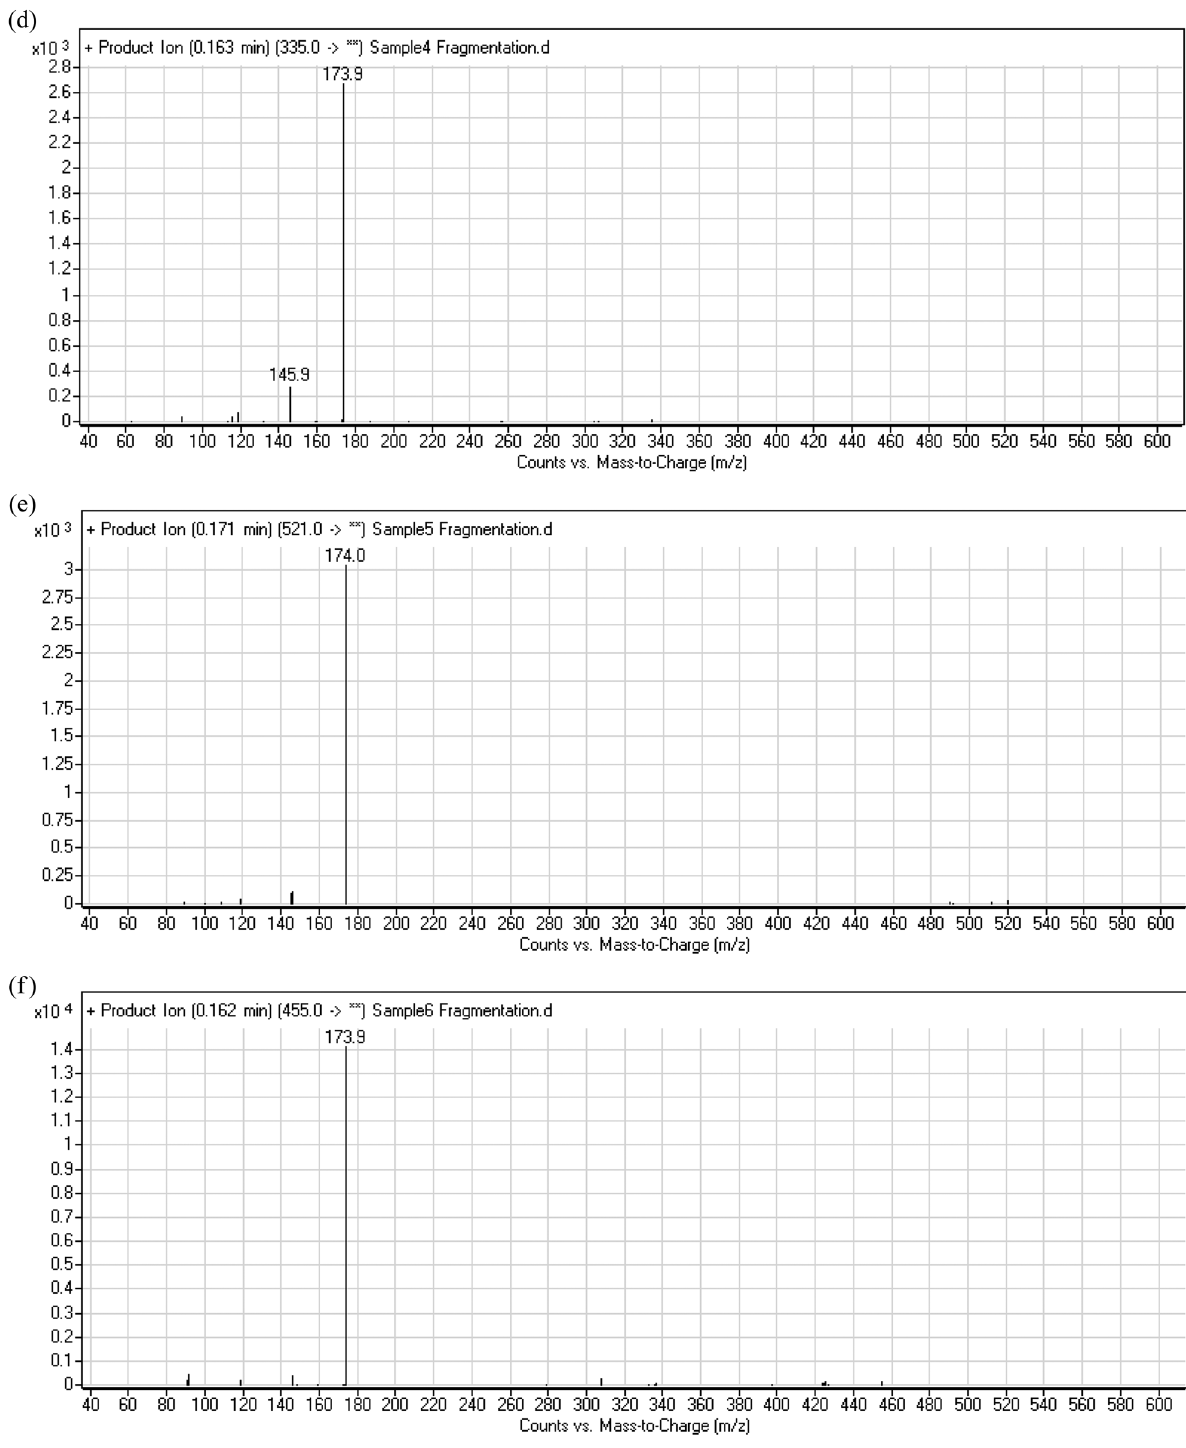
Figure 3: Product ion mass spectra of compounds 2 ( a ) , 3 ( b ) , 4 ( c ) , 5 ( d ) , 6 ( e ) and 7 ( f ) . ( PI fragmentation of compound 1 – 7 gave one fragment ion at m / z 174 that represented the breakage of the carbohydrazide bond. Compound 5 ( without any substitutions ) showed an additional m / z at 146 that represented 3 - iminoindolin - 2 - one fragment.